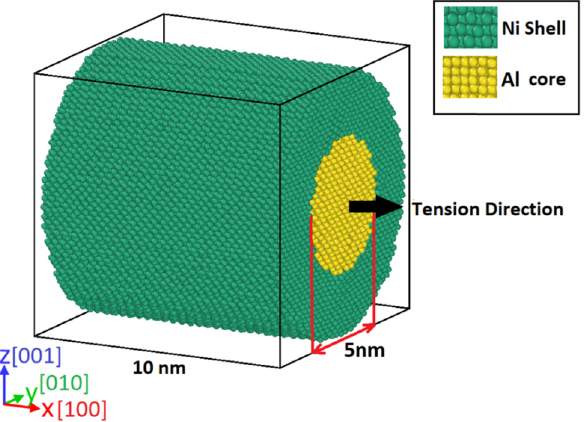
Figure 1: Ni – Al core – shell nanowire construction step. Taken from OVITO software.